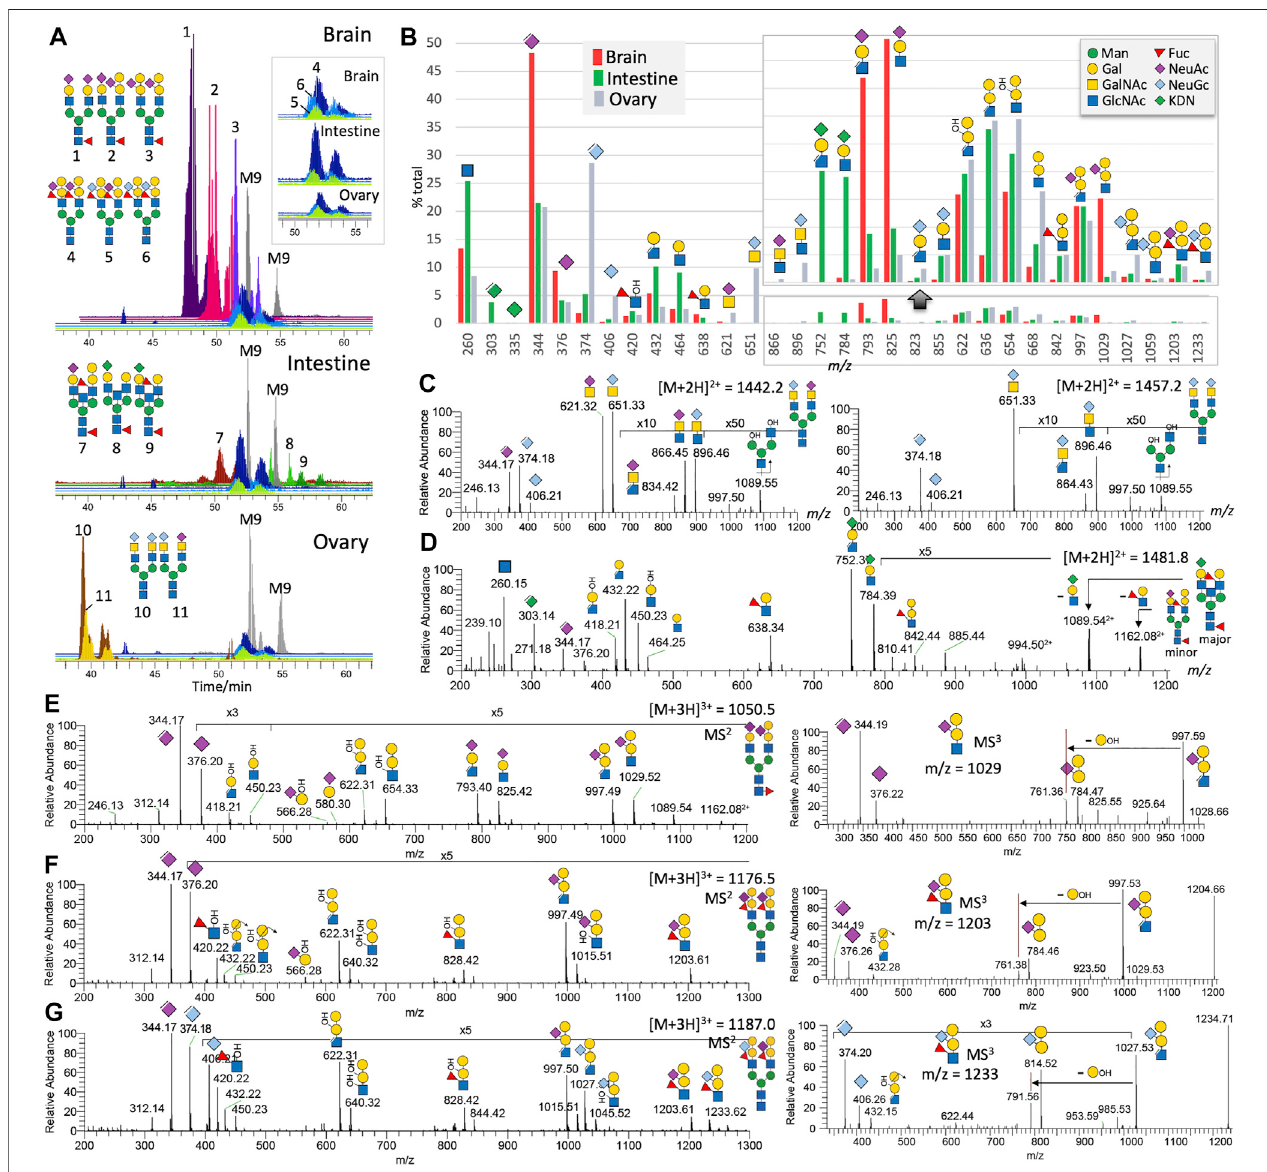
FIGURE 1 | Non-sulfated N-glycans of adult zebra fi sh. LC-MS/MS analysis of the non-sulfated N-glycans identi fi ed at least 11 distinct major complex-type structures, some of which are essentially the same structures but sialylated by different NeuAc and NeuGc combinations. Their brain-, intestine-, and ovary-speci fi c distributionpatternsandrelativeabundancescanbeinferredfromtheoverlaidXICplotsnormalizedtothoseofthecommonlyfoundMan 9 GlcNAc 2 (M9)structureineach of the three organs (A) . The overlaid XIC plots for the 3 related N-glycans commonly found in all three organs. The summed intensity for each of the detected diagnosticMS 2 ionsnormalizedtotheirtotalprovidesanoverallassessmentoftherelativeabundanceandorgan-speci fi cdistributionofthethreesialicacidsandvarious glycotopes (B) . A portion of the bar chart was magni fi ed to highlight the fragment ions of the ± Gal-(NeuGc/NeuAc/KDN)Gal-( ± Fuc)GlcNAc glycotopes. The origins of most of the annotated diagnostic MS 2 ions in (B) can be found in representative sets of MS 2 spectra shown here for the biantennary N-glycans carrying NeuAc/Gc- sialylated LacdiNAc (C) , KDN-sialylated LacNAc (D) , Gal-(NeuAc)Gal-GlcNAc (E) , Gal-(NeuAc)Gal-(Fuc)GlcNAc (F) , and Gal-(NeuGc)Gal-(Fuc)GlcNAc (G) , along with the MS 3 spectra for each of the last three glycotopes (E-G, right panels). A full set of MS 2 spectra for all the 11 major N-glycans are additionally provided as Supplementary Figure S3 . Assigned glycotopes and glycans in this and all other fi gures were annotated using the recommended Symbol Nomenclature for Glycan (Varkietal.,2015),asshowninthetoprightinset.EliminationofaMeOHmoietyor3-substituentfromthesialicacidsandHexNAccreatesadoublebond,asindicatedin thecartoonsymbol.AssignmentofGal/ManandGlcNAc/GalNAcisbasedonpriorknowledgeofthezebra fi shglycotopesasdeterminedinapreviousstudy(Yamakawa et al., 2018). Bisecting GlcNAc is not distinguished from a non-extended terminal GlcNAc on additional antenna.